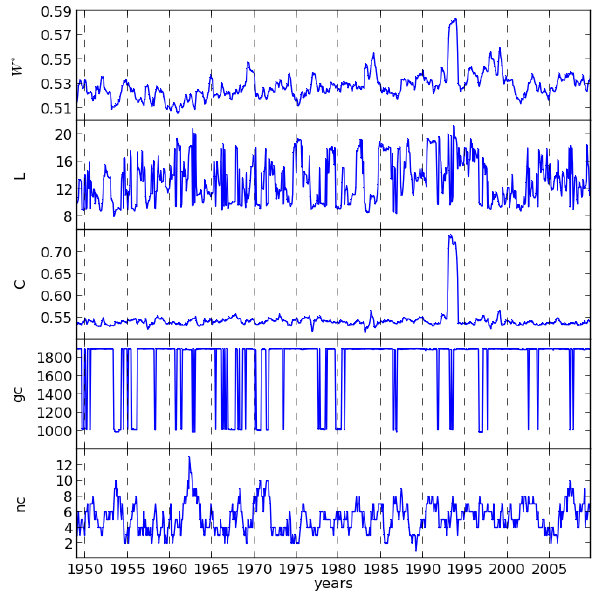
Fig. 13. Evolution of the graph-theoretical properties of the extra- tropics subgraph.